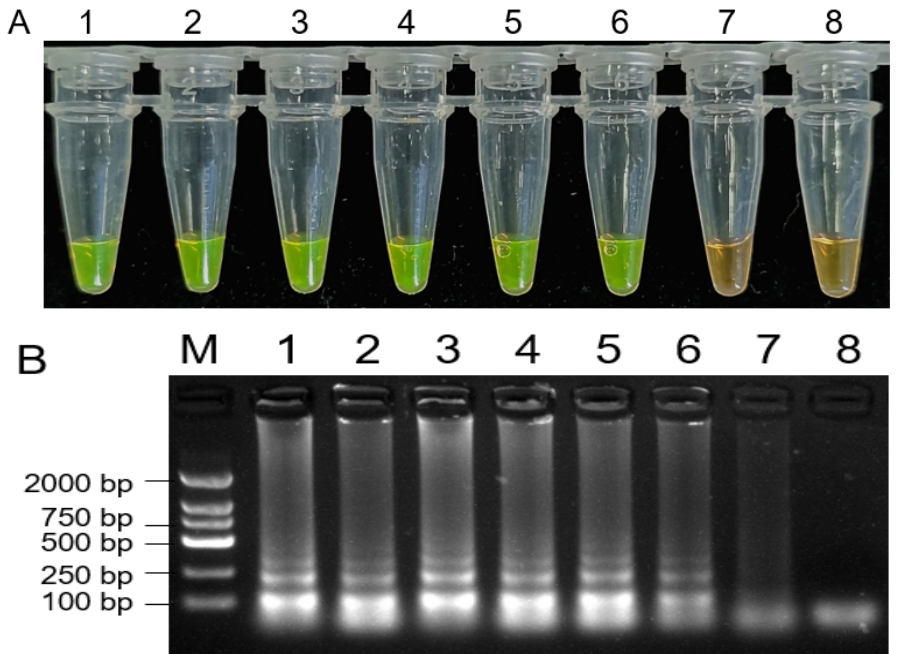
Figure 6. Assessment of LAMP assay sensitivity for the detection of Botryosphaeria dothidea. 1000 × SYBR Green I color change-based LAMP product detection ( A ). Agarose gel electrophoresis-based LAMP product detection ( B ). DNA isolated from Botryosphaeria dothidea isolate was subjected to serial 10-fold dilution (10 ng–10 − 6 ng) and served as a template in LAMP assays. M: DNA marker 2 k, 1–7: 10 ng, 10 − 1 ng, 10 − 2 ng, 10 − 3 ng, 10 − 4 ng, 10 − 5 ng, 10 − 6 ng, 8: water.